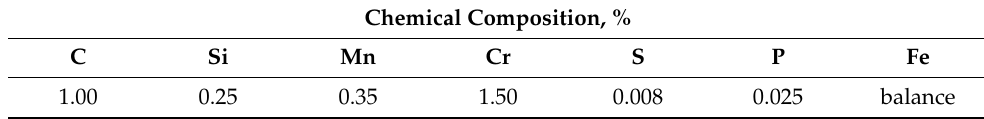
Table 1. Chemical composition of the steel ball. Chemical Composition,